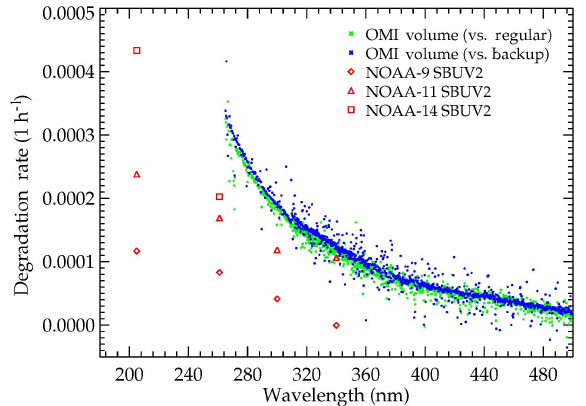
Figure 28. The fractional change in the QVD diffuser per hour of solar exposure relative to the regular and backup Al diffuser.